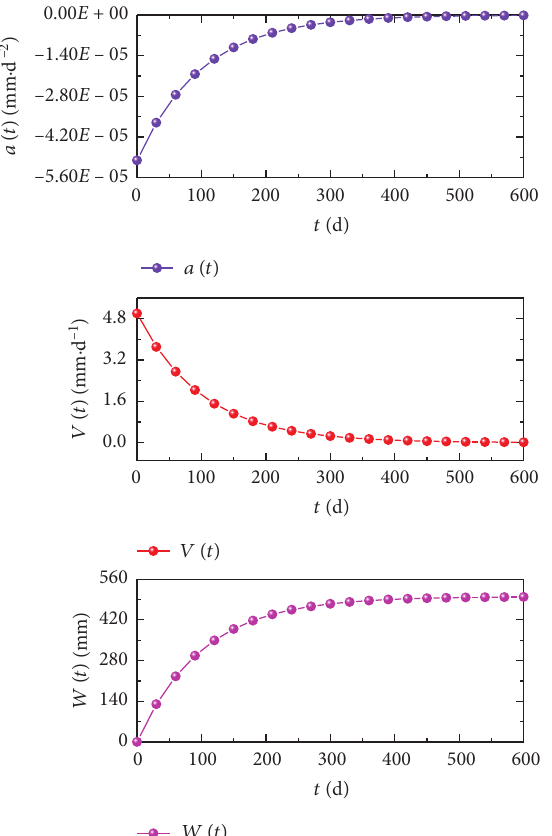
Figure 1: The Knothe time function